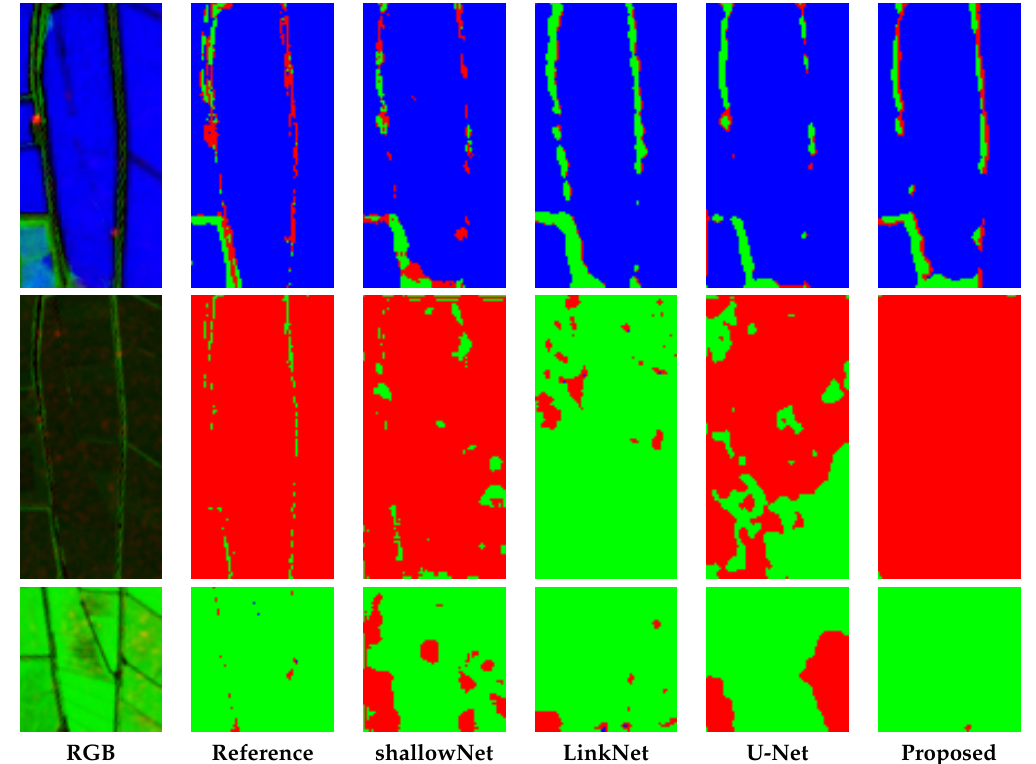
Figure 7. Zoomed details of segmentation results for a subset of SoA approaches, and our proposed method (W-Net). In the first column, a false colour images (R: VH, G: NDVI, B: MNDWI) is shown; in the other columns, the segmentation maps obtained with the methods under comparison are depicted. In all the segmentation maps green, red and blue pixels represent Vegetation, Bare Soil and Water,